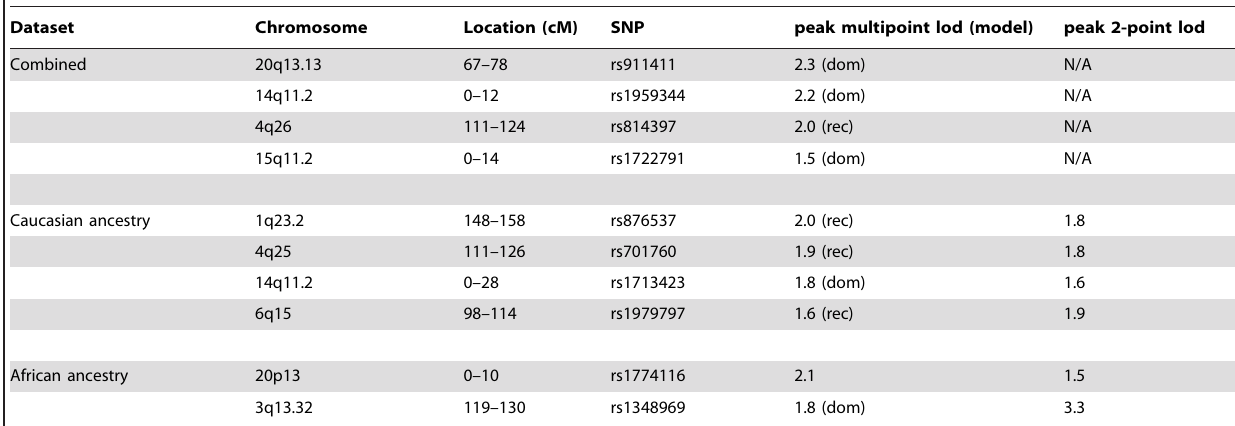
Table 2. Linkage analysis